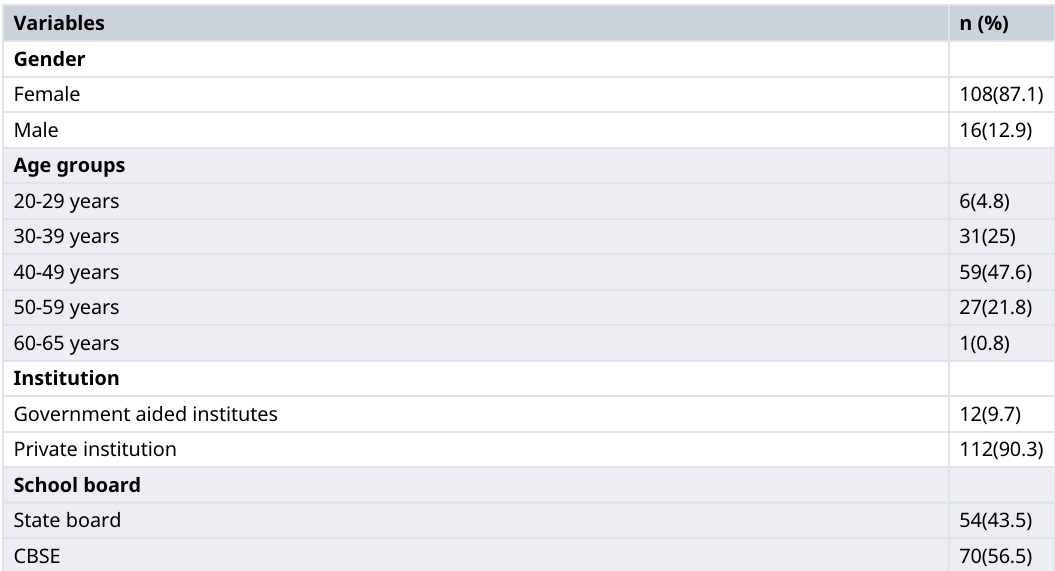
Table 1. Basic demographic characteristics (CBSE: Central Board of Secondary